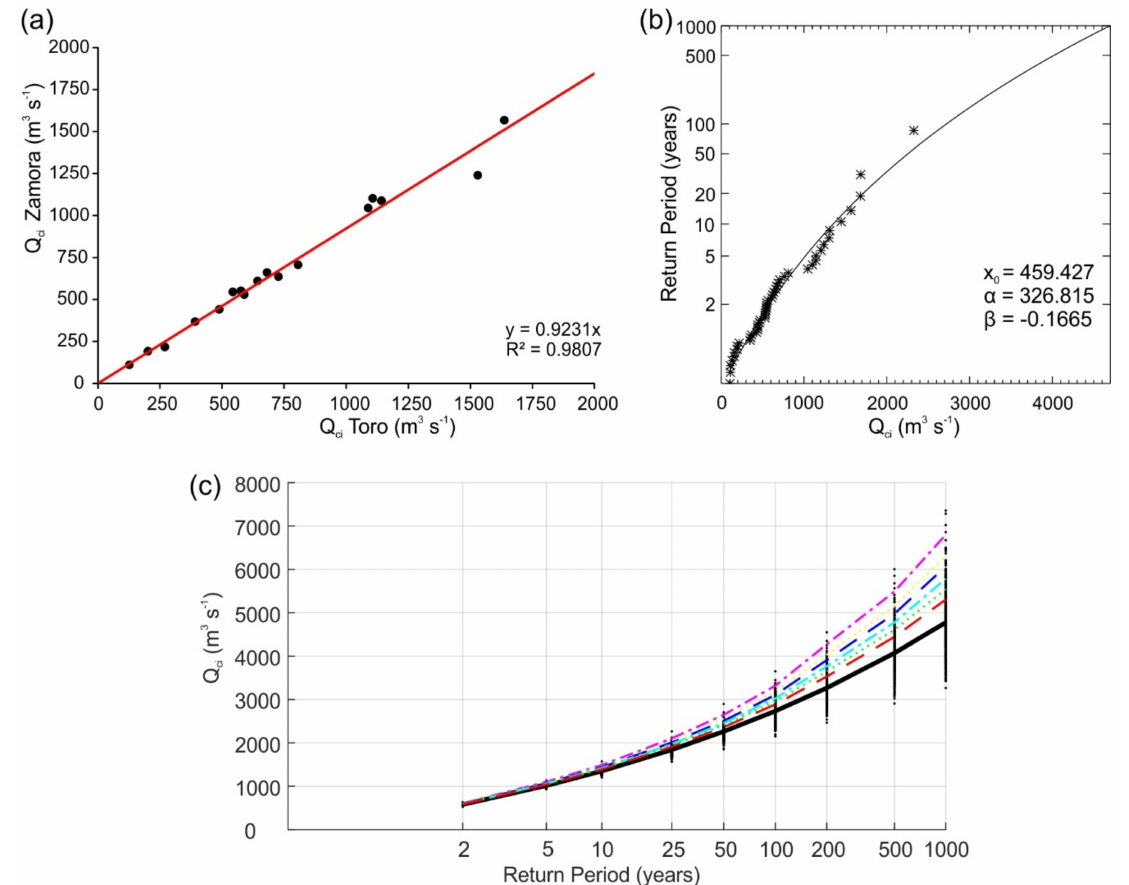
Figure 3. Results of annual maximum peak flow value statistical analysis: ( a ) linear regression fit between Zamora city and Toro city gauge stations; ( b ) flow frequency analysis for the extended gs2121 maximum annual peak flow record; ( c ) quantile and confidence intervals from Monte Carlo analysis. The solid black line defines the Monte Carlo quantiles, the dashed red line shows the 50% confidence interval, the dotted green line shows the 67% confidence interval, the dash-dot light blue line shows the 80% confidence interval, the dashed dark blue line shows the 90% confidence interval, the dotted yellow line shows the 95% confidence interval, and the dash-dot pink line shows the 99% confidence interval for the 500-year return period peak